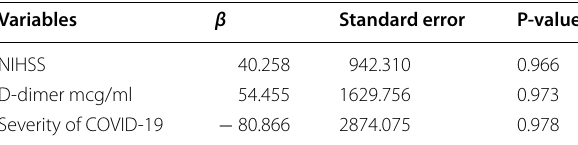
Table 3 The impact of COVID-19 on the stroke outcomes